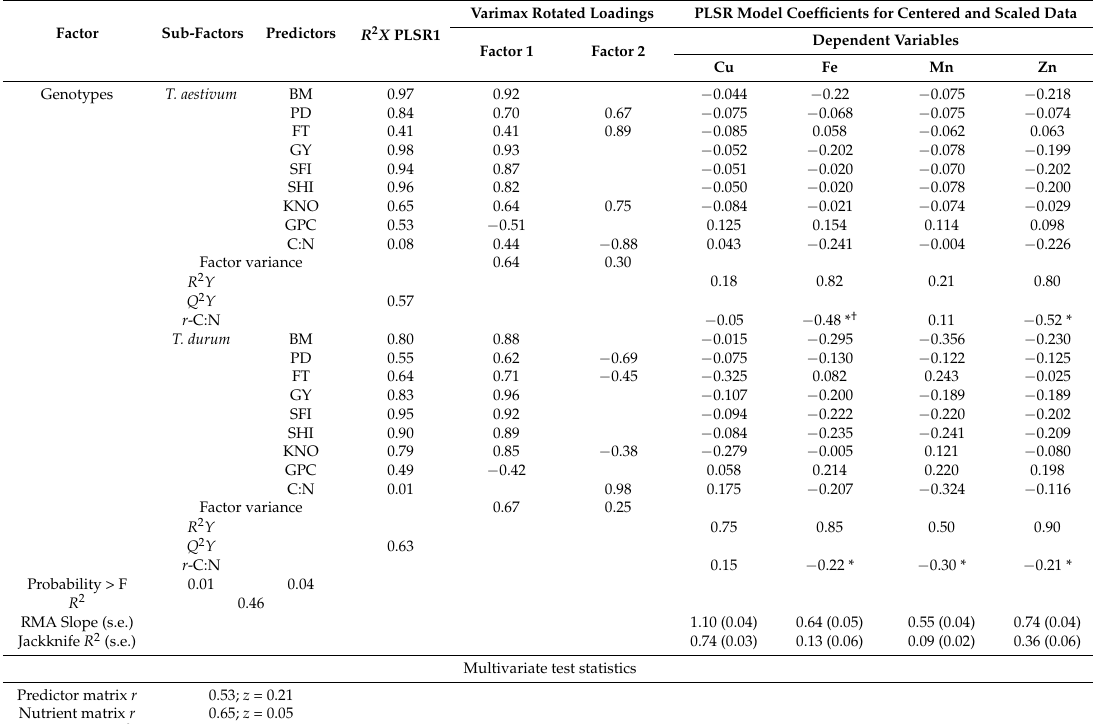
Table 3. Multiple comparisons between wheat genotypes representing T. aestivum and T. durum wheat species using partial least squares regression (PLSR), factor analyses, prediction of micronutrients as functions of phenotypic plasticities, multivariate distances, and matrix correlations between predictors and between predicted